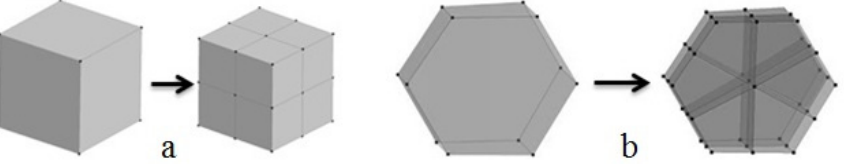
Figure 4. Adding new nodes at the center of faces and at the midpoint of edges: ( a ) a hexahedral cell, ( b ) a cell in the form of an arbitrary polyhedron. ( b ) a cell in the form of an arbitrary